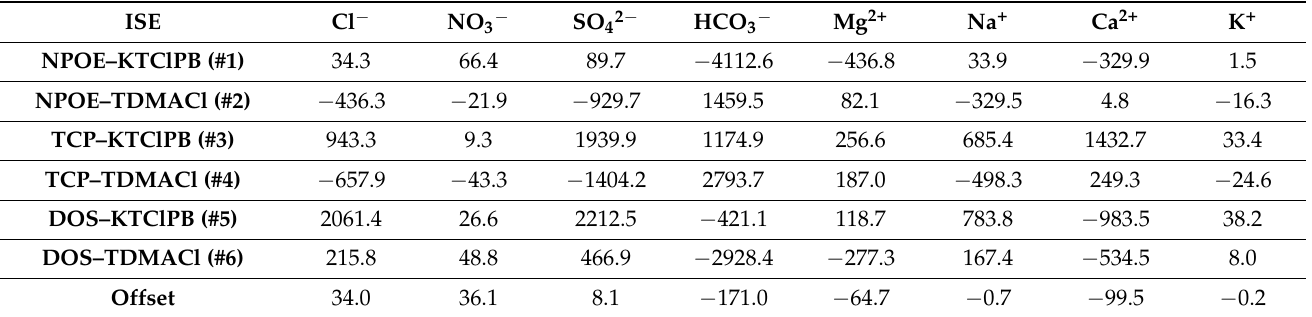
Table 5. Fitting coefficients ( w k ) for each sensor and offset obtained for the linear model predictor for each ion.